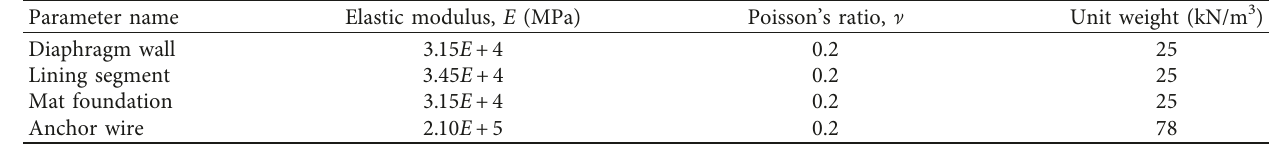
Table 6: Main parameters of the support